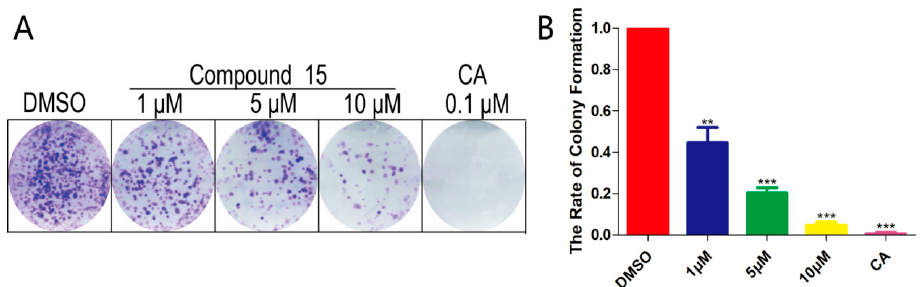
Figure 2. Compound 15 was shown to inhibit the colony formation of cancer cell lines. ( A ) The colony formation of A549 cells could be reduced by compound 15 in a dose dependent manner. Compound 15 incubated with cancer cells for 7 days. ( B ) Quantification of the rate of colony formation described in A. Statistically significant differences are presented as * p < 0.05, ** p < 0.01, *** p < 0.001, compared with the control group. CA: Camptothecin.